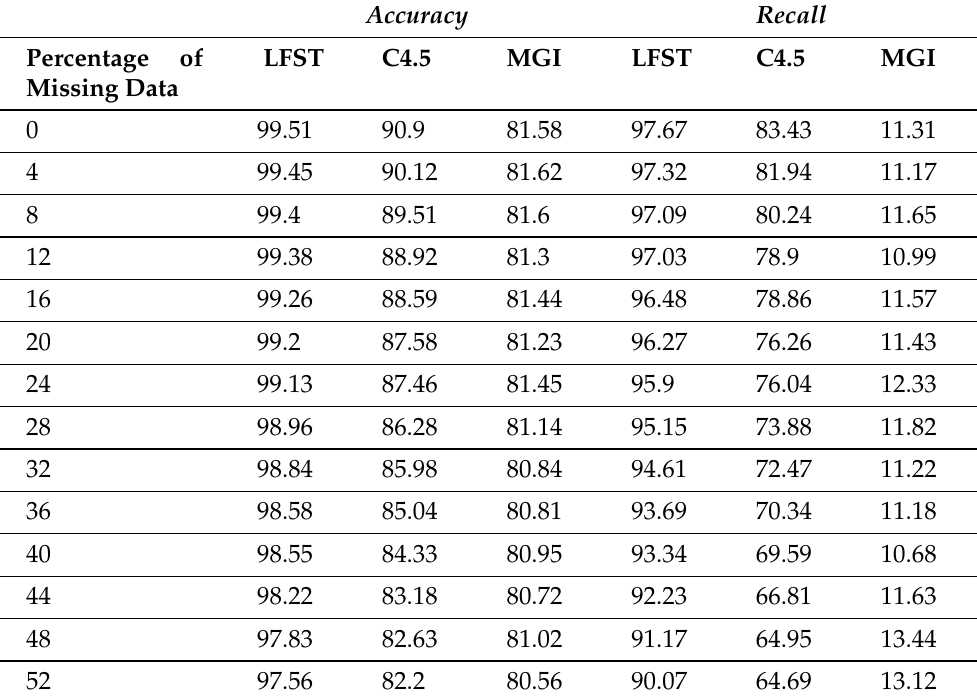
Table 3. Average accuracy and recall for the three algorithms in